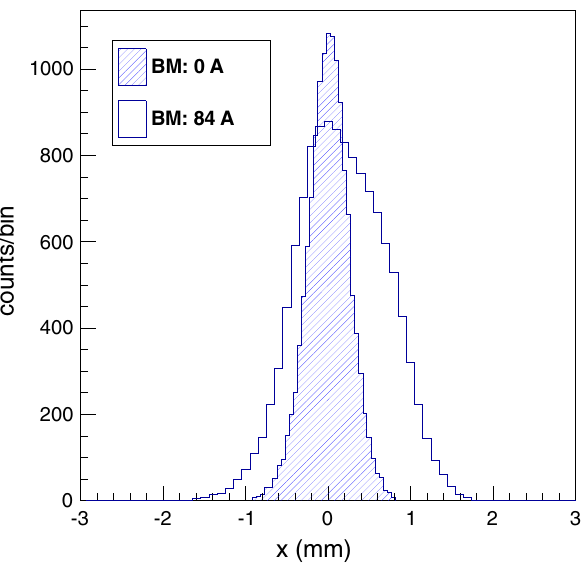
FIG. 9. Profiles of the beams having passed through the slits (SL) and bending magnet (BM). The solid histogram is the profile when the BM is set to 0 A (straight beam), and the hatched histogram is that when the BM is set to 84 A (bended by 15 degrees). The peak positions of each histogram are adjusted to